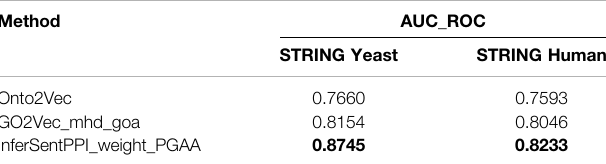
TABLE 4 | AUC_ROC of three GO Information-based methods on yeast and human dataset from